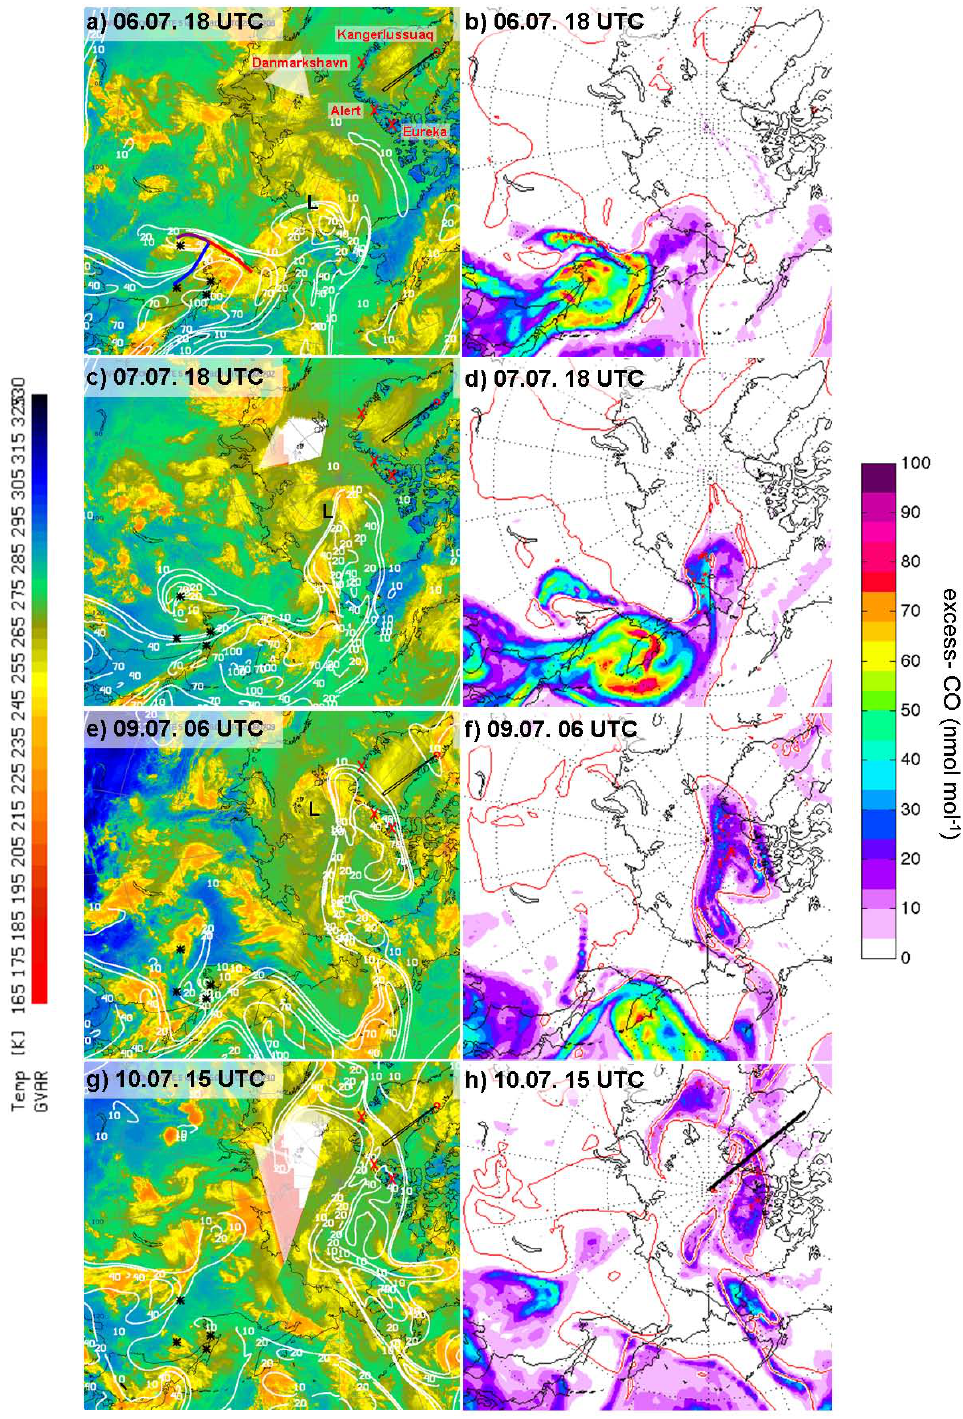
Fig. 6. Cross-polar transport of the Asian pollution. (a) and (b) 6 July, 18:00UTC, (c) and (d) 7 July, 18:00UTC, (e) and (f) 6 July, 09:00UTC, (g) and (h) 10 July, 15:00UTC. Left panels: Satellite composite images with colour-coded cloud top temperatures (see colour- scaling at the left). White contour lines show FLEXPART Asian CO for the column above 9km. Black asterisks indicate locations of weather stations in the region of the WCB (marked by the fronts in panel (a) ). The Falcon flight path is superimposed in panel (g) . Right panels: FLEXPART Asian CO tracer plotted on the 340K isentrope (see-colour-scaling on the right). Red line gives the location of the dynamical tropopause (2PVU) at the 325K surface. The red crosses indicate the position of the WCB forward trajectories. The black line shows the location of the cross section presented in Fig. 8. For more details see